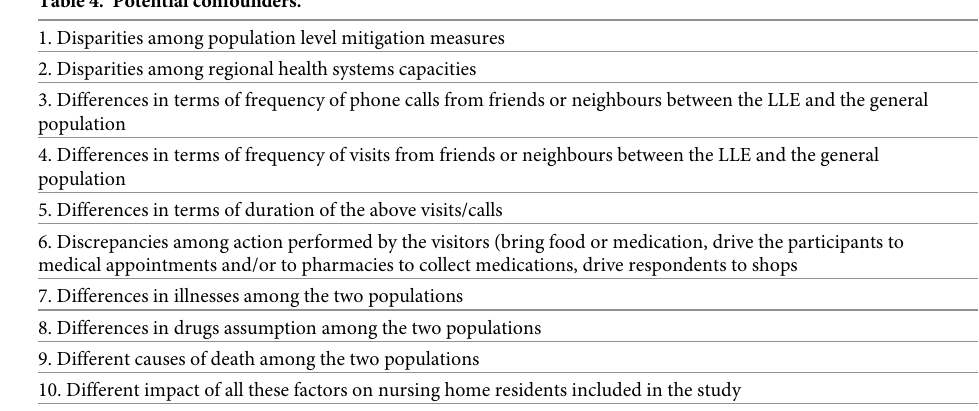
Table 4. Potential